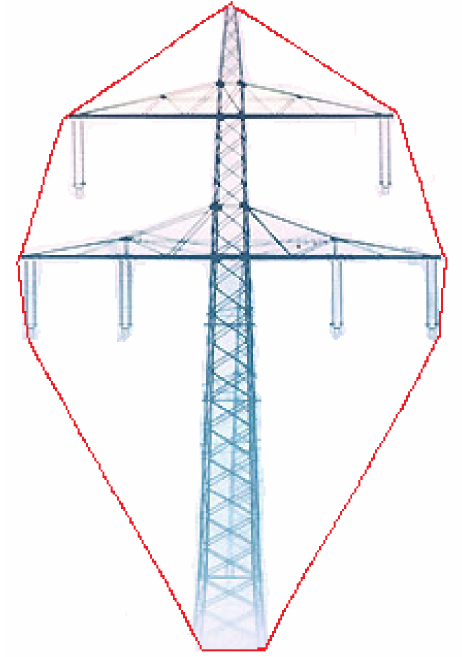
Figure 2. The occupied area of a